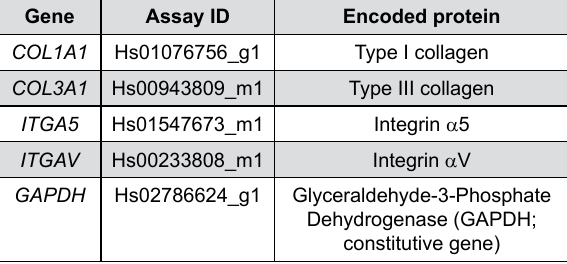
Figure 1- TaqMan assays used to analyze gene expression